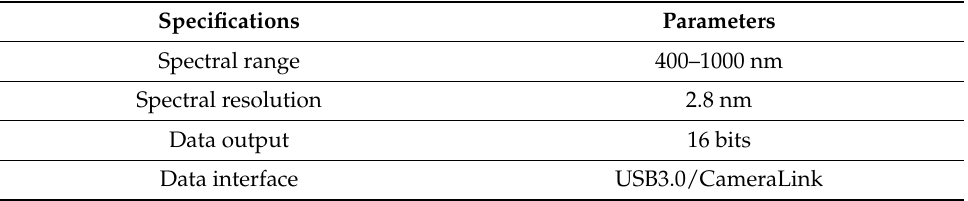
Table 1. Parameters of Gaiafield-V10E-AZ4 hyperspectral camera.